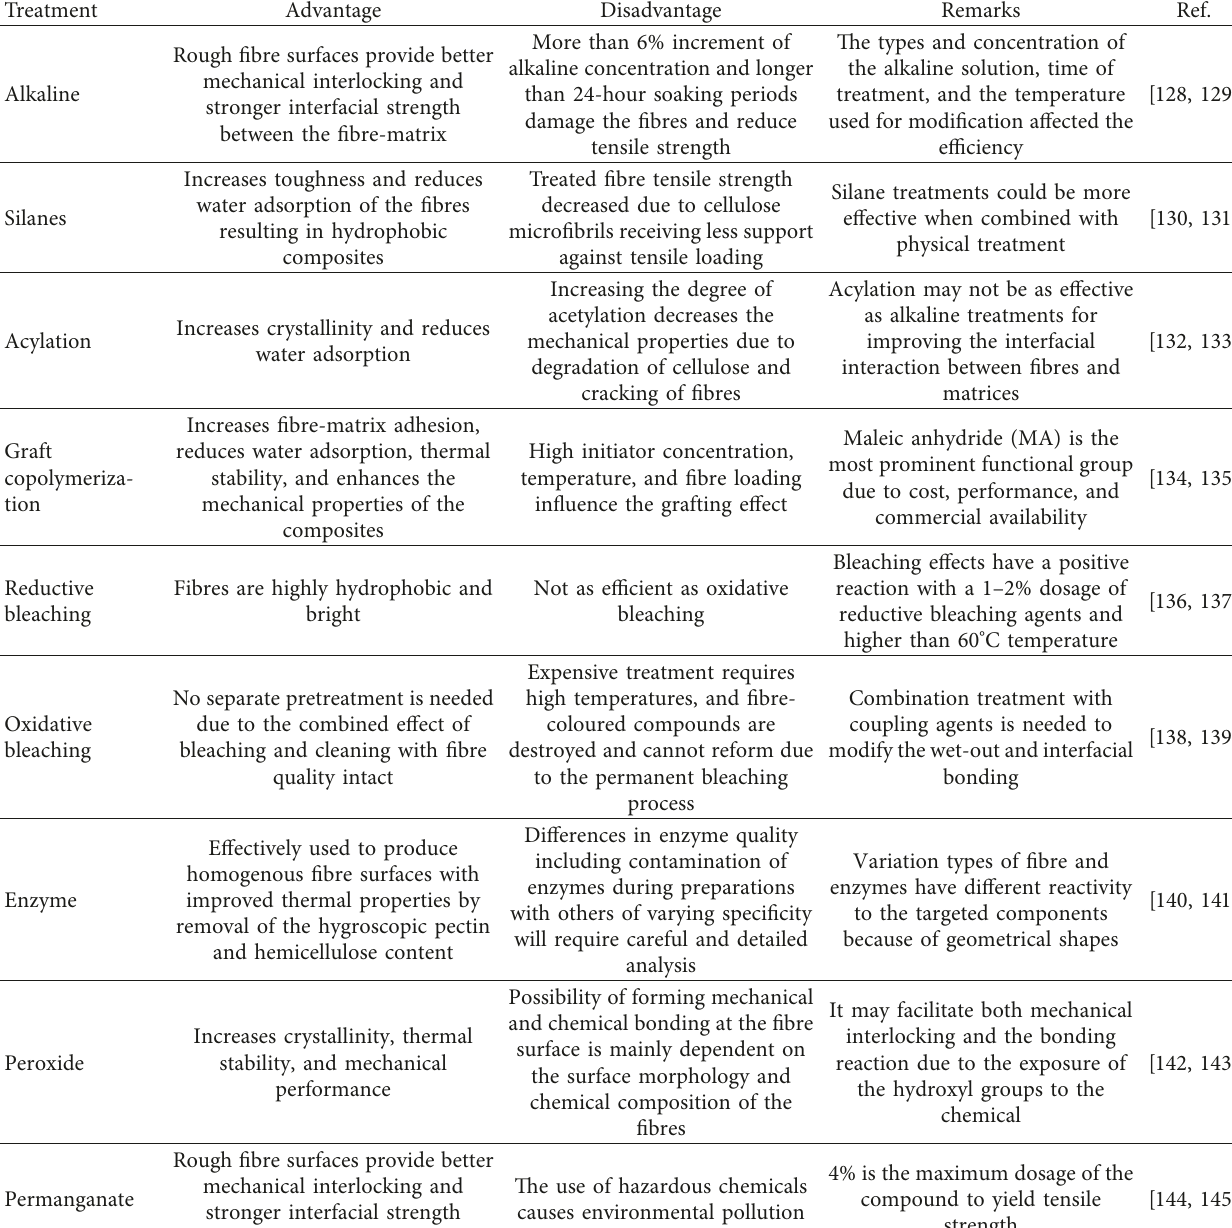
Table 4: Advantages and disadvantages of fibre chemical